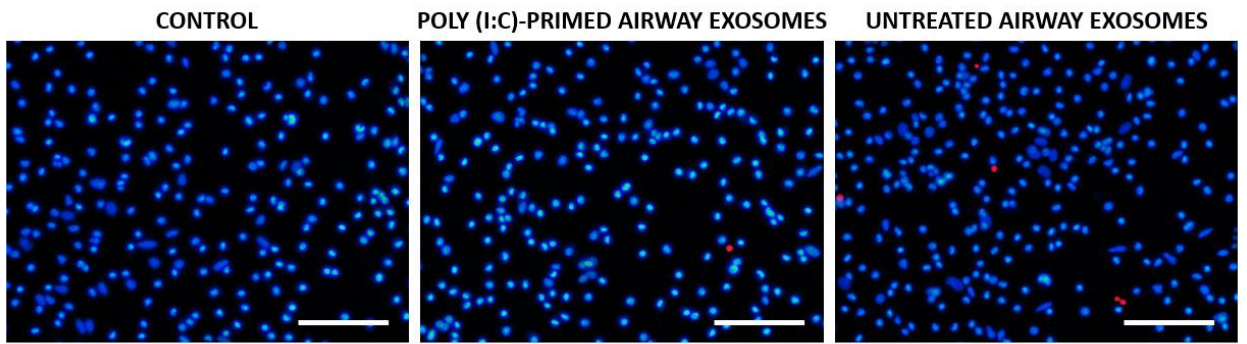
Figure A3. Representative images of viability evaluation of airway exosome-treated microglial cultures. The cells were stained with Hoechst33342 to visualise all nuclei blue and with propidium iodide to detect dying cells with lost plasma membrane integrity (red fluorescence of the nuclei).